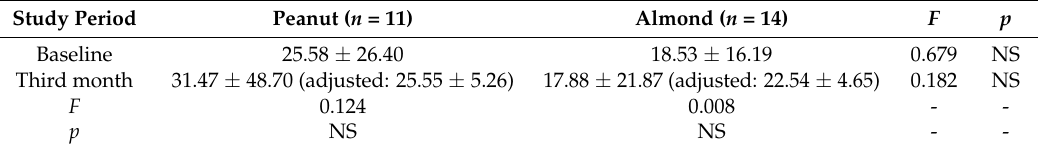
Table 9. Comparison of albumin/creatinine (ACR) (x ± s, mg/g) in the two